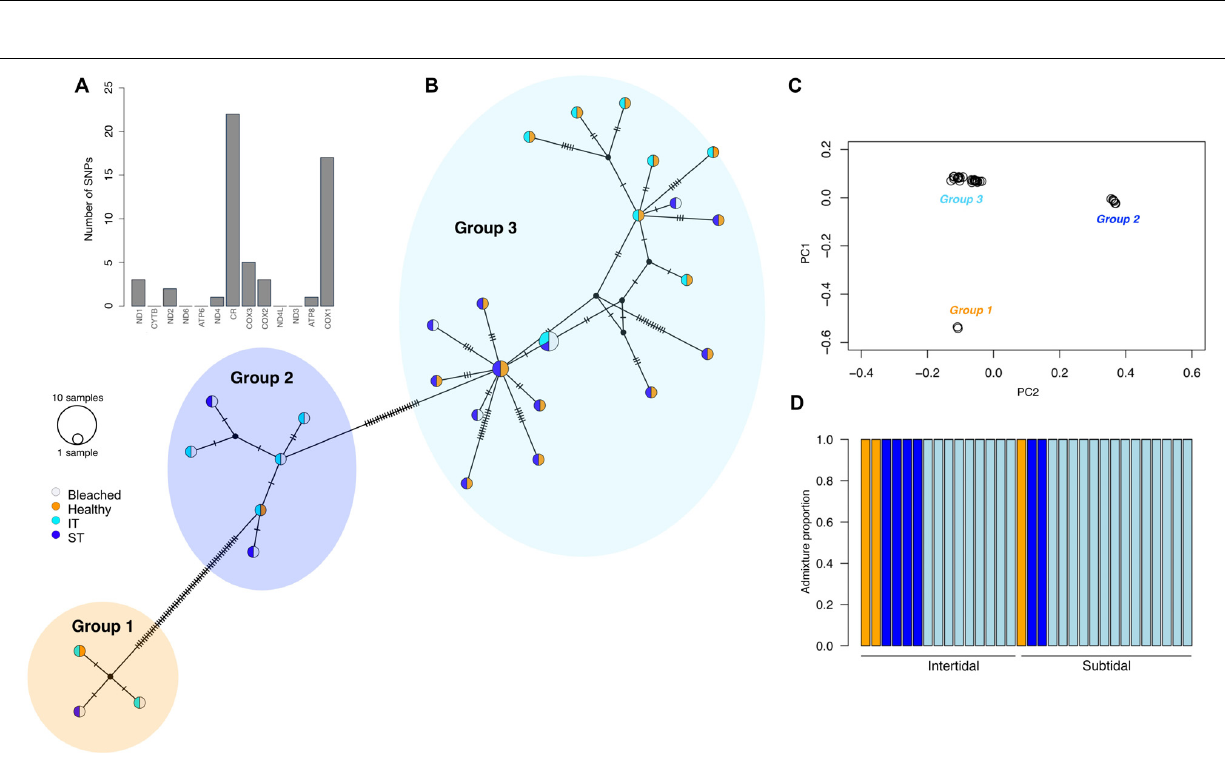
Frontiers in Marine Science |